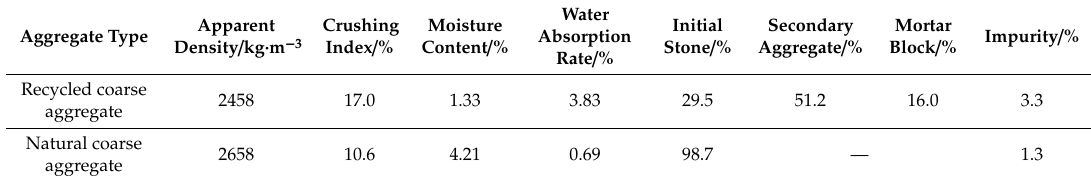
Table 1. Physical properties of recycled coarse aggregate (RCA) and natural coarse aggregate (NCA). Aggregate